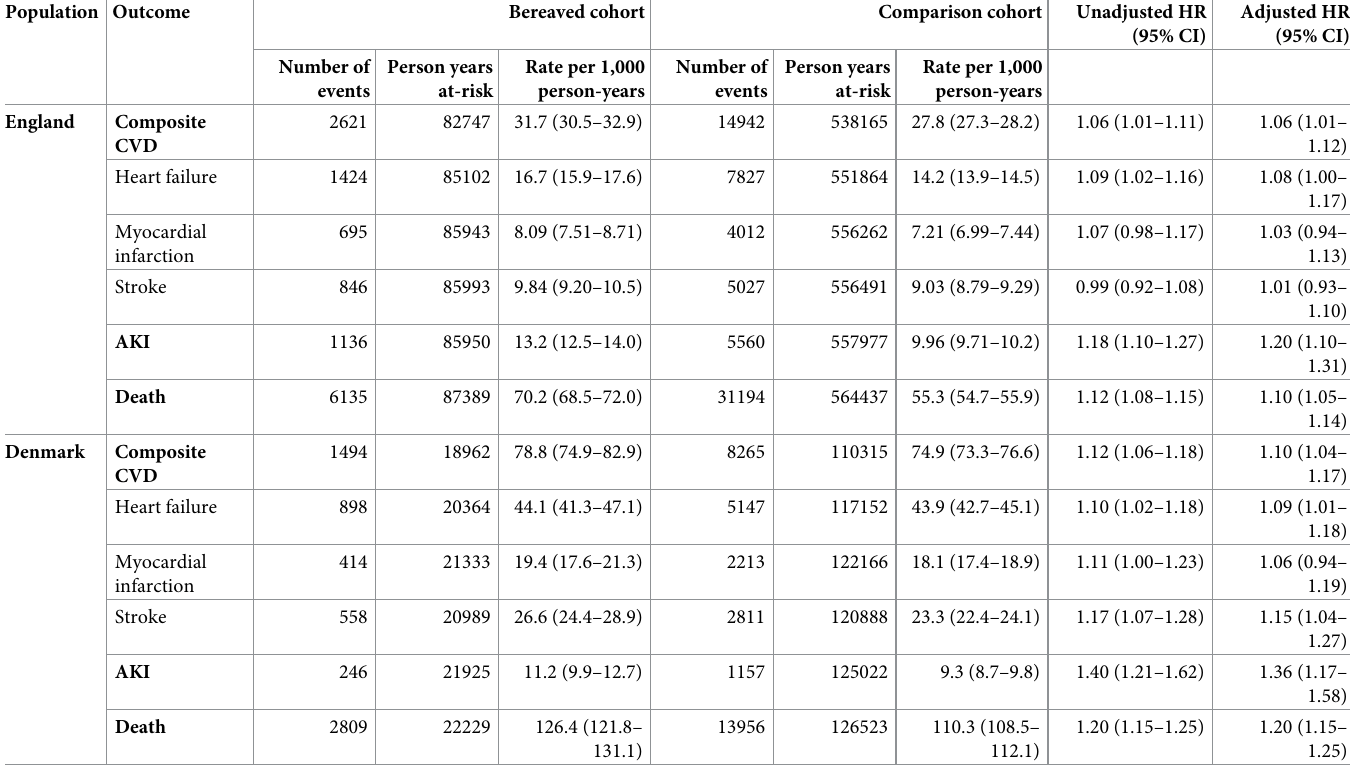
� England: adjusted for comorbidities (CKD stage, cerebrovascular disease, heart failure, chronic obstructive pulmonary disease, diabetes, hypertension, ischaemic heart disease, myocardial infarction, peripheral artery disease, connective tissue disease, dementia, peptic ulcers, non-haematological cancer, haematological cancer, liver disease), history of AKI, smoking status, alcohol consumption, BMI category, IMD category. � Denmark: adjusted for comorbidities (cerebrovascular disease, heart failure, chronic obstructive pulmonary disease, diabetes, hypertension, ischaemic heart disease, myocardial infarction, peripheral artery disease, connective tissue disease, dementia, peptic ulcers, non-haematological cancer, haematological cancer, liver disease), history of AKI, and educational